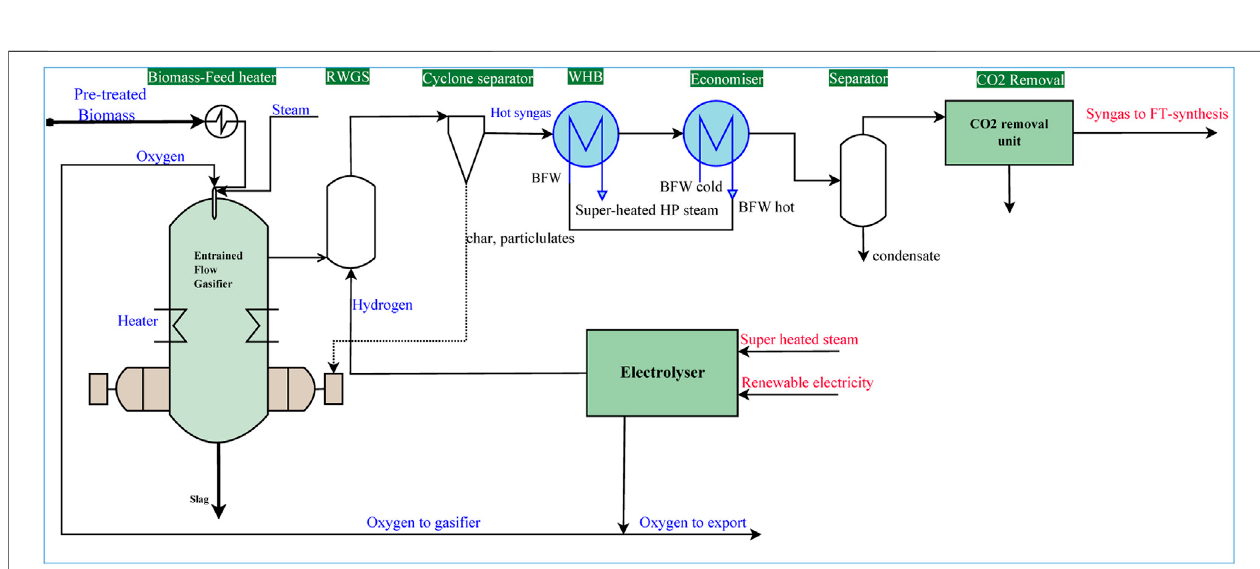
FIGURE 2 | Process fl ow diagram for the investigated